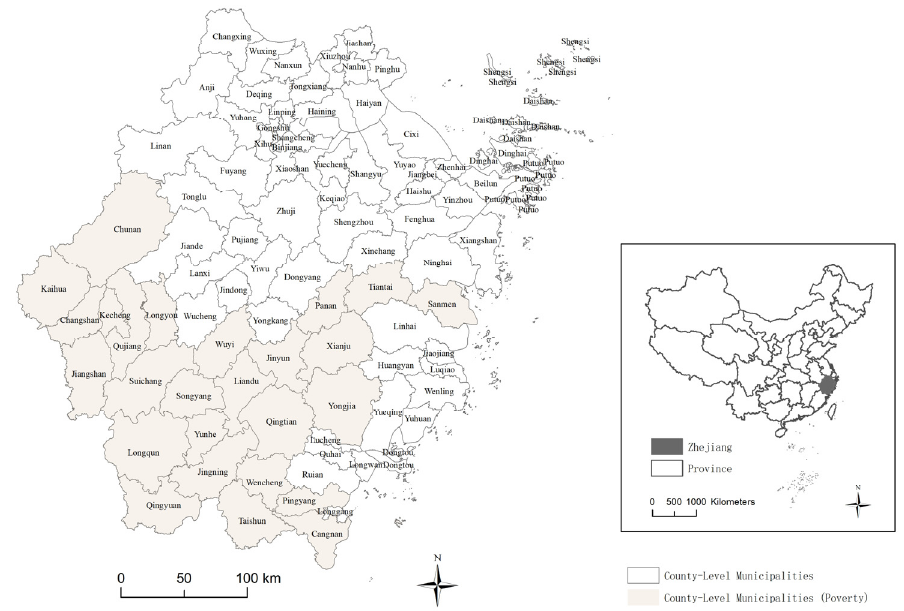
Figure 2. Map of the study area.